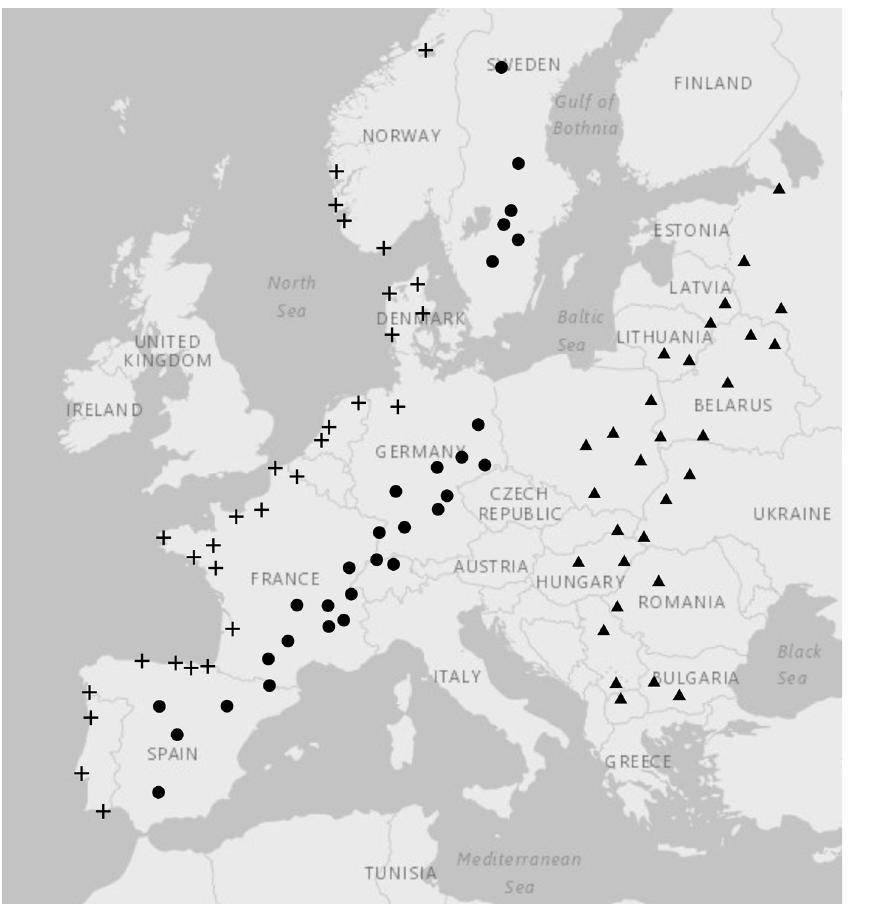
Figure 2. Map displaying the location of the 90 cities forming